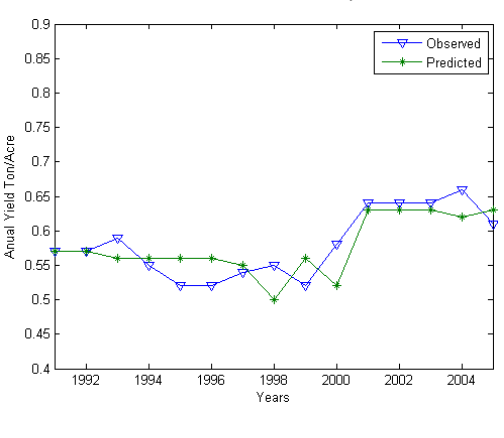
Figure 4. Predicted and observed aus yield for